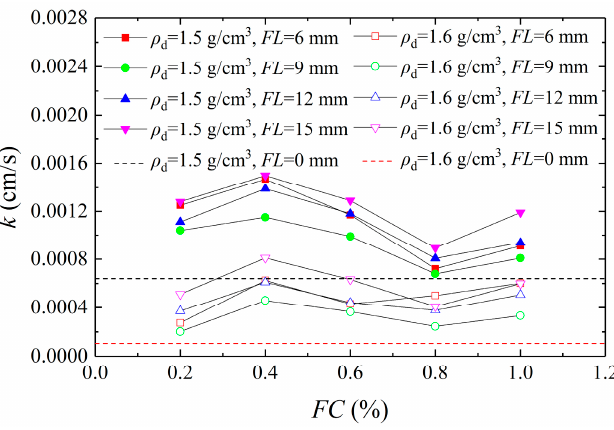
Figure 3. Curves of permeability coefficient versus fiber content